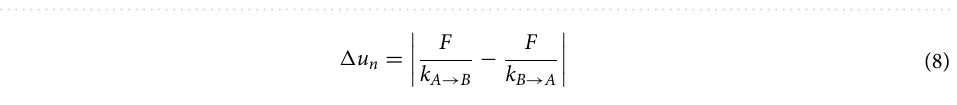
Figure 4. Topological mechanics of monoatomic lattices with nonreciprocal elastic springs. ( a – c ) Three configurations of a mass-spring system representing a monoatomic lattice ( m indicates the atomic mass). Nonreciprocal springs made of the developed metamaterial are considered such that the stiffness is different when the spring is stretched/compressed from two opposite ends (i.e., k A B > k B A ). The free body diagrams → → of the spring forces and the inertia forces are represented when ( a ) atoms vibrate to the right, ( b ) when atoms vibrate to the left, and ( c ) when each two neighbor atoms vibrate in two opposite directions. ( d ) Representations of the different stiffnesses of the considered nonreciprocal springs under tension and compression. ( e ) Classical q band structures ω (nondimensional frequency ( ω/ω 0 ) versus nondimensional wavenumber ( q )) are obtained when atoms vibrate to the right with positive nonreciprocal elasticity ( ǫ > 0 ). ( f ) Complex band structures (cid:30) (cid:31) are obtained when atoms vibrate to the left with negative nonreciprocal elasticity ( ǫ < 0 ) (real band structures ω q r q m (above) and imaginary band structures ω (below)). ( g ) The band-gap ( �ω ) versus the nonreciprocal elasticity parameter ( ǫ (cid:30) (cid:30) (cid:31) (cid:31)